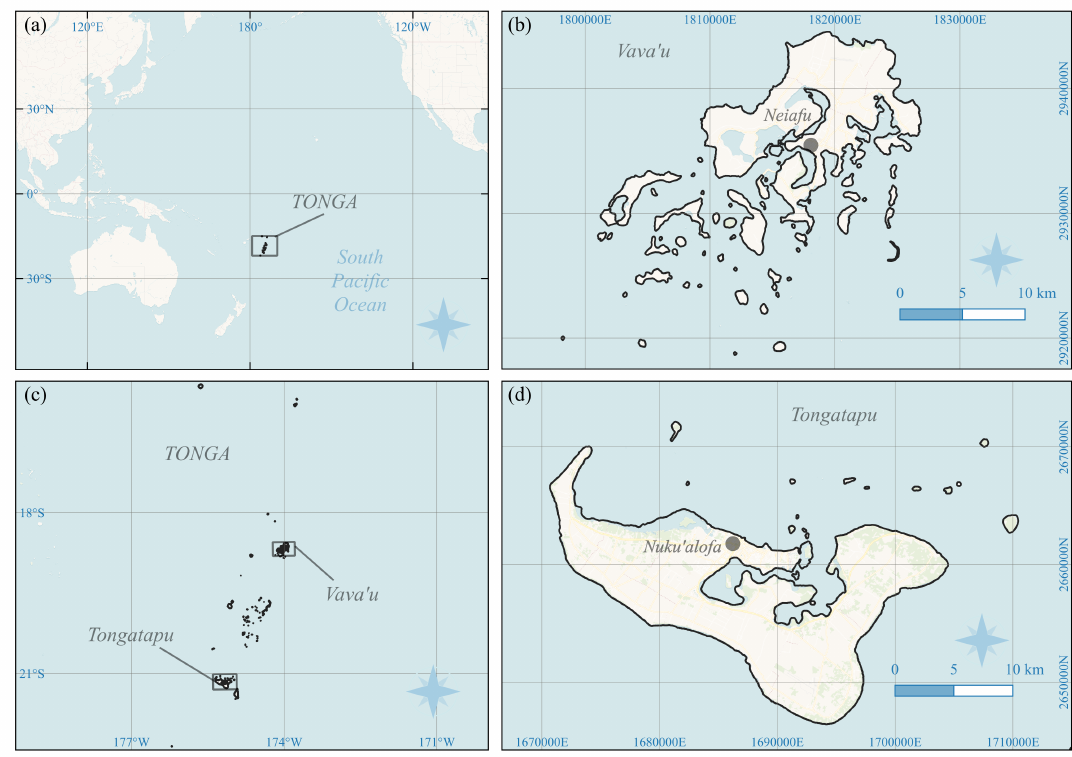
Figure 1. Tonga (a) is an archipelago of 176 islands (b). Case studies focused on the islands of Vava’u (c) and Tongatapu (d).